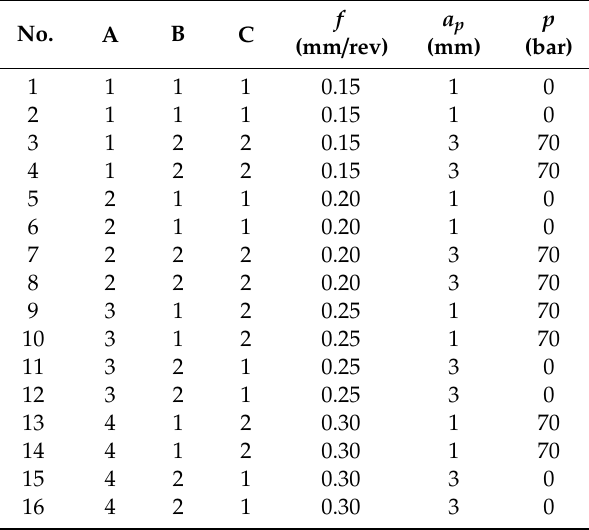
Table 3. Research plan with real